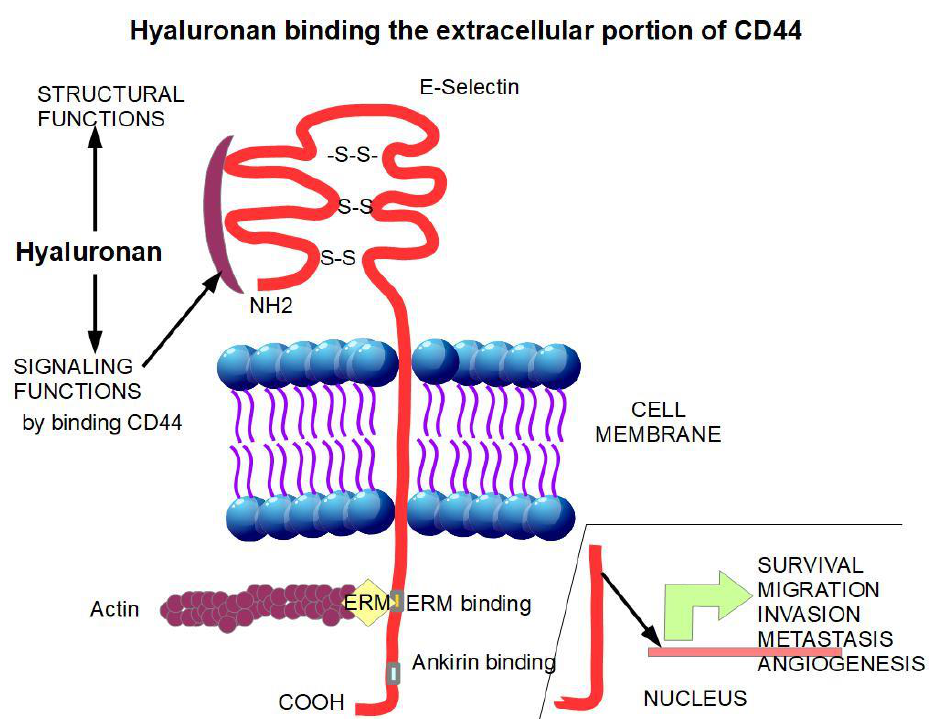
Figure 5. The binding of hyaluronan to the extracellular domain of CD44 initiates pro-tumoral signaling. The intracellular portion of CD44 undergoes intra-membrane proteolysis releasing the intra-cytoplasmic domain that promotes the transcription of genes that induce survival, migration, invasion, metastasis, and angiogenesis. [75].